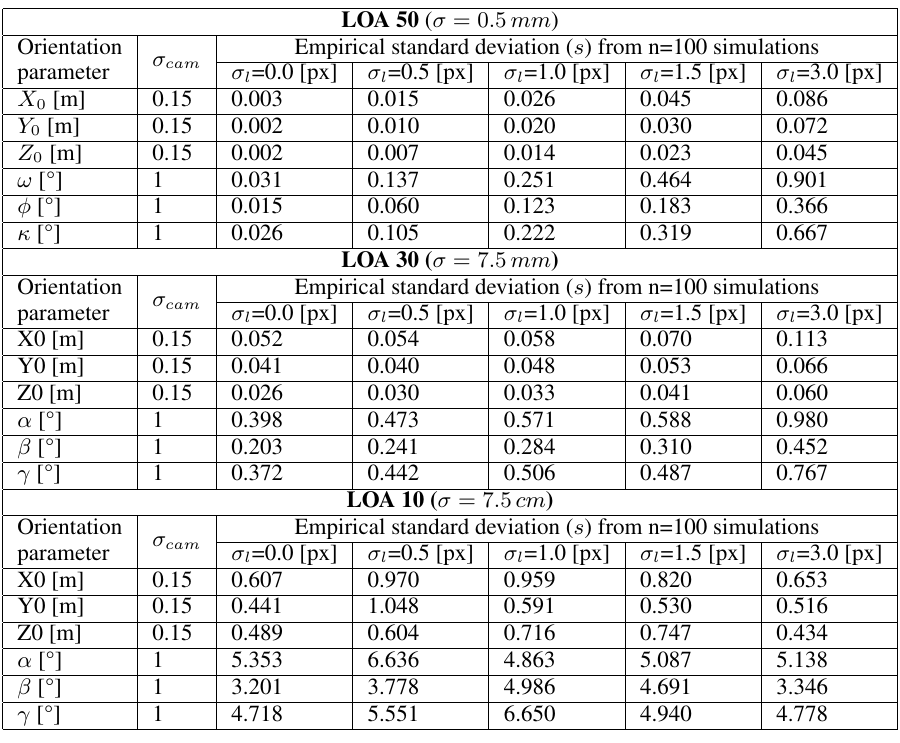
Table 2. Results on pose estimation with different image line quality and different LOA from 100 simulations